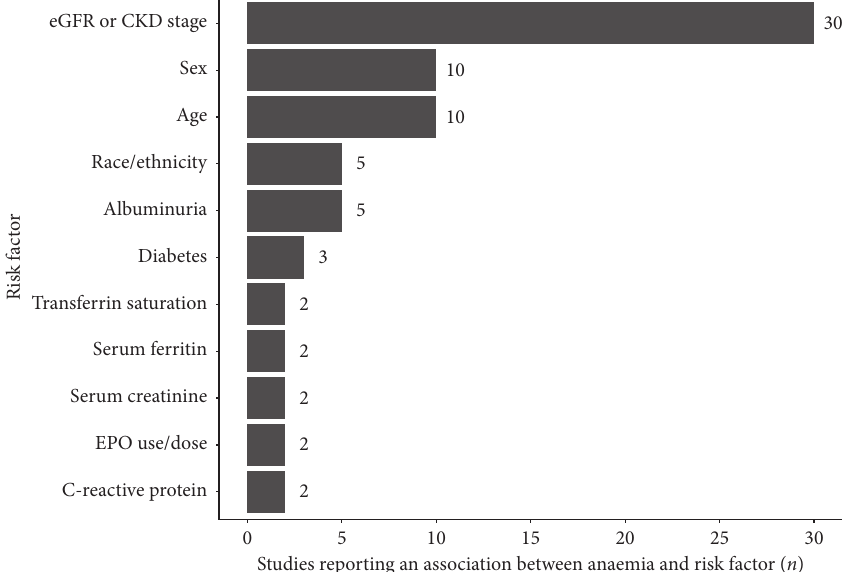
Figure 2: Risk factors associated with the presence of anaemia identified by more than one included study. All-cause mortality CV mortality